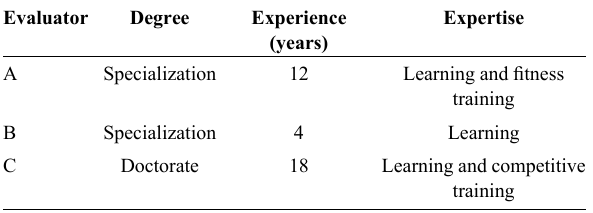
Table 1 - Degree, years of swimming experience, and expertise area of the evaluators.